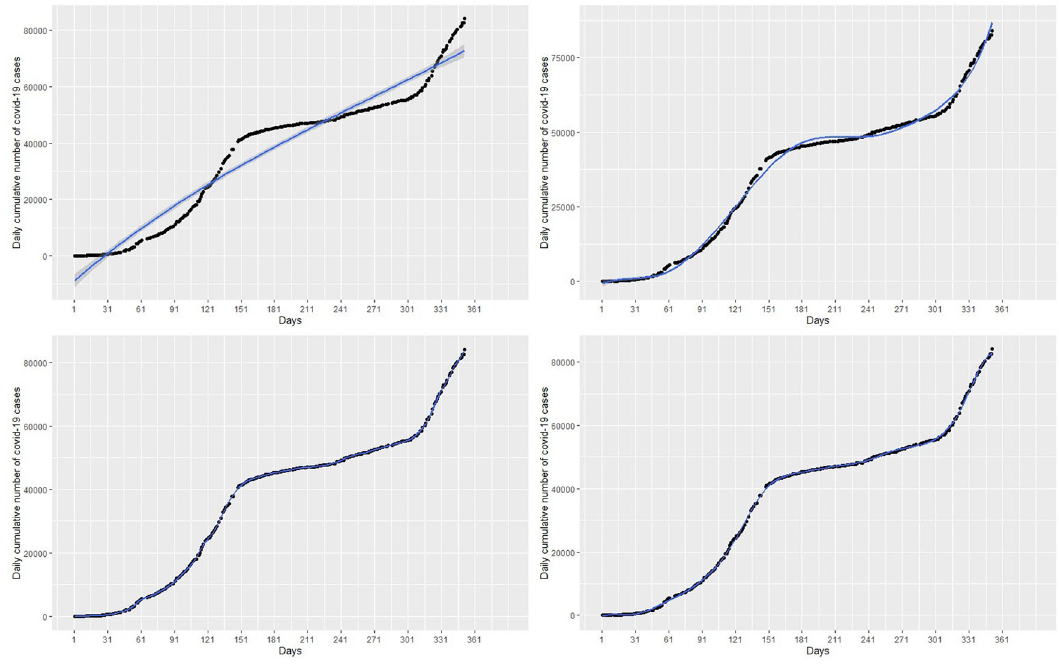
Figure 4. Fit of the spline regression models with 3 knots (top-left panel), 8 knots (top-right panel), 14 knots (bottom-left panel), and 50 knots (bottom-right panel) to the cumulative